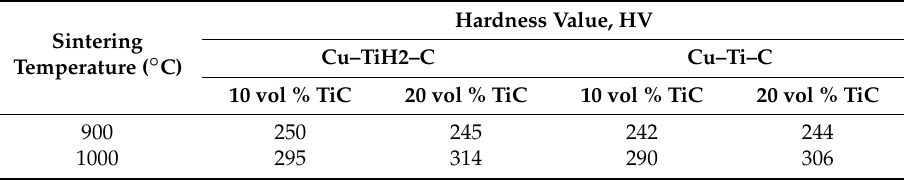
Table 4. Hardness values of nanocomposites sintered at 900 and 1000 °C.